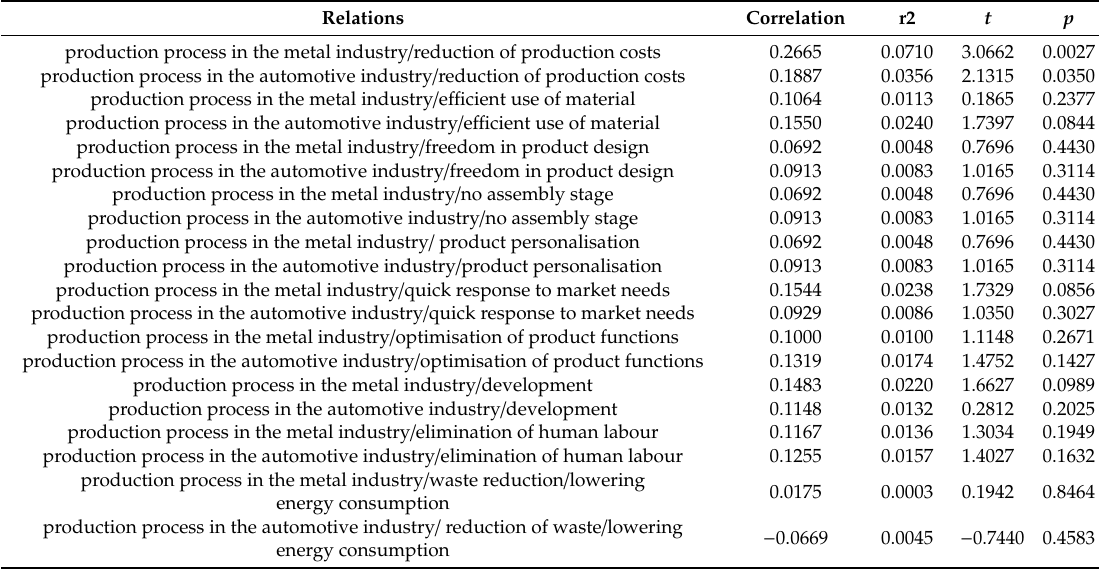
Table 3. Correlation analysis: production